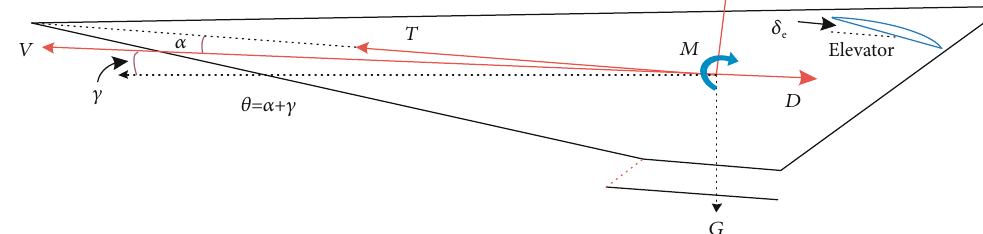
Figure 1: AHV force